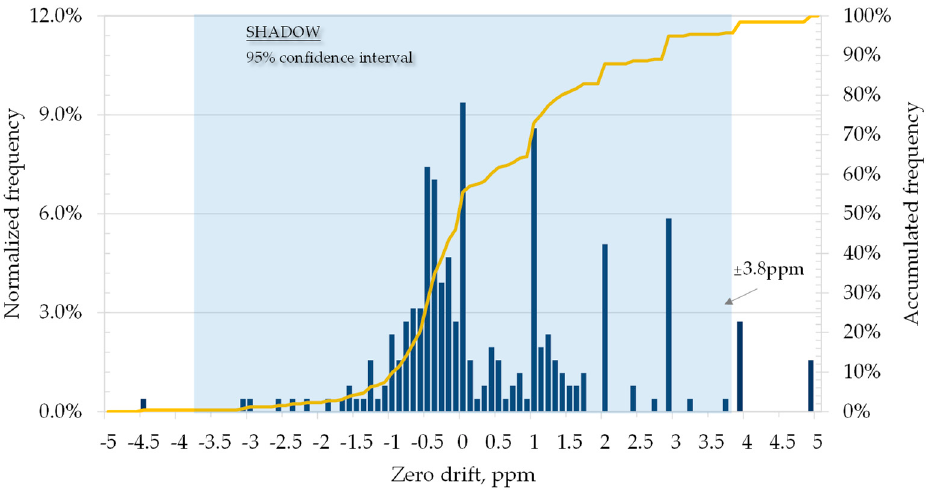
Figure 3. Statistical distribution of zero-drift events up to a certain concentration level.